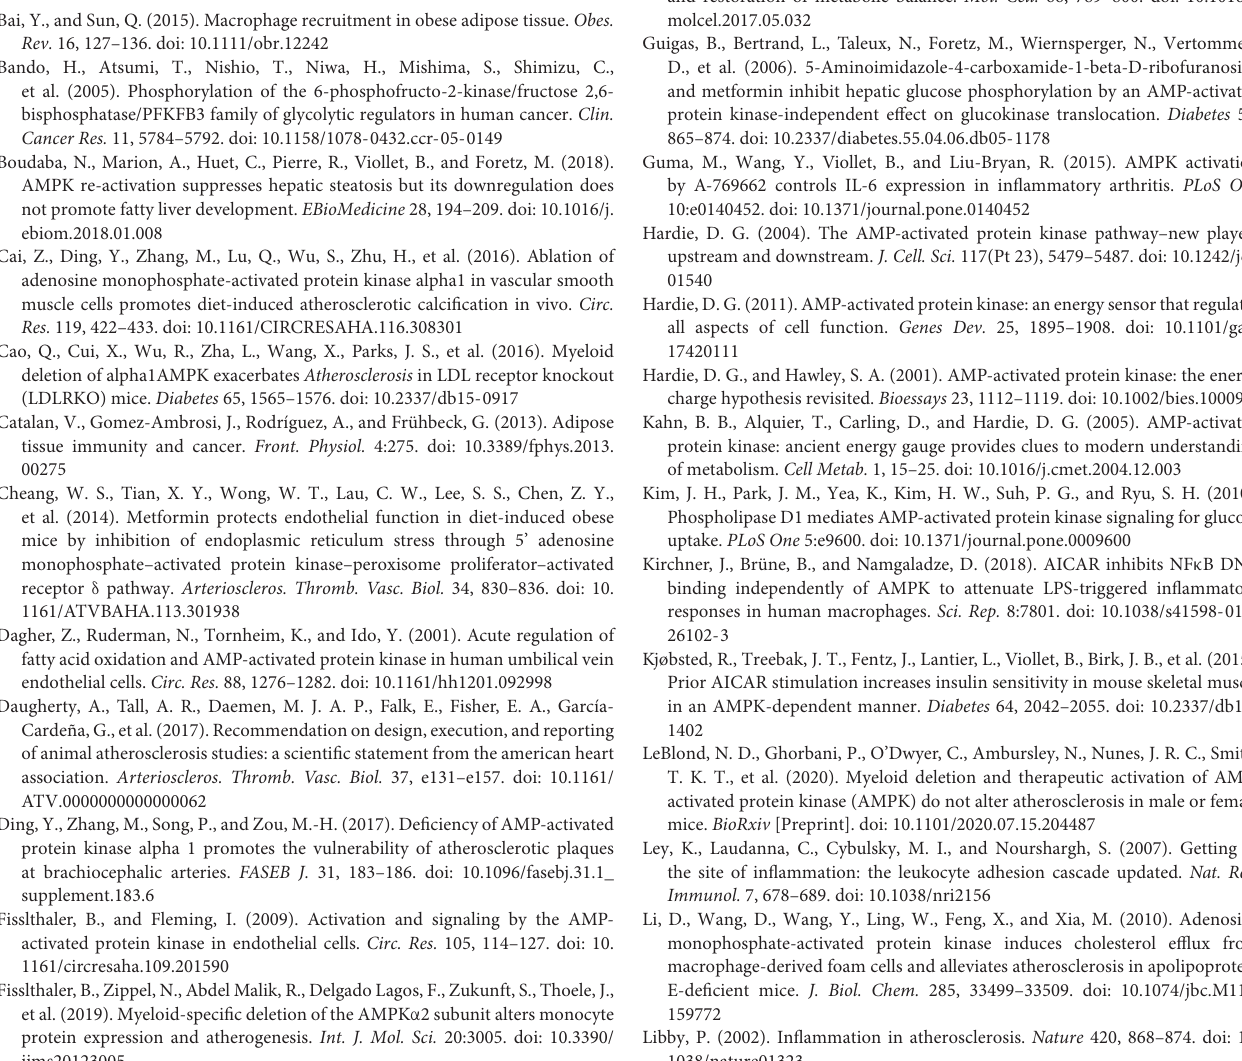
Supplementary Figure 5 | (A) Levels of total cholesterol in plasma of Apoe − / − / Prkaa1 WT (female, n = 8; male, n = 8), Apoe − / − / Prkaa1 (cid:49) M ϕ (female, n = 7; male, n = 7) mice fed Western diet for 16 weeks. (B) Levels of triglyceride in plasma of Apoe − / − / Prkaa1 WT (female, n = 7; male, n = 8), Apoe − / − / Prkaa1 (cid:49) M ϕ (female, n = 5; male, n = 7) mice fed Western diet for 16 weeks. (C) Levels of glucose in plasma of Apoe − / − / Prkaa1 WT ( Prkaa1 (cid:49) M ϕ , female, n = 7; male, n = 9)